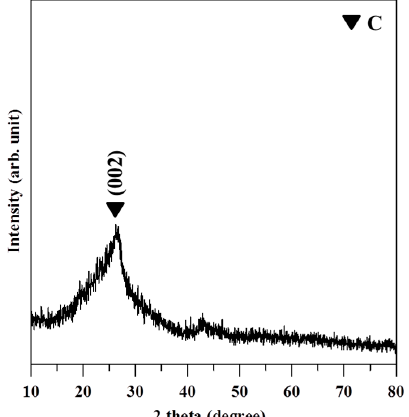
Figure 3. X-ray diffraction (XRD) pattern of reduced GO shows the strongest peak at 25.8° and the distance of d (002) is 0.348 nm.